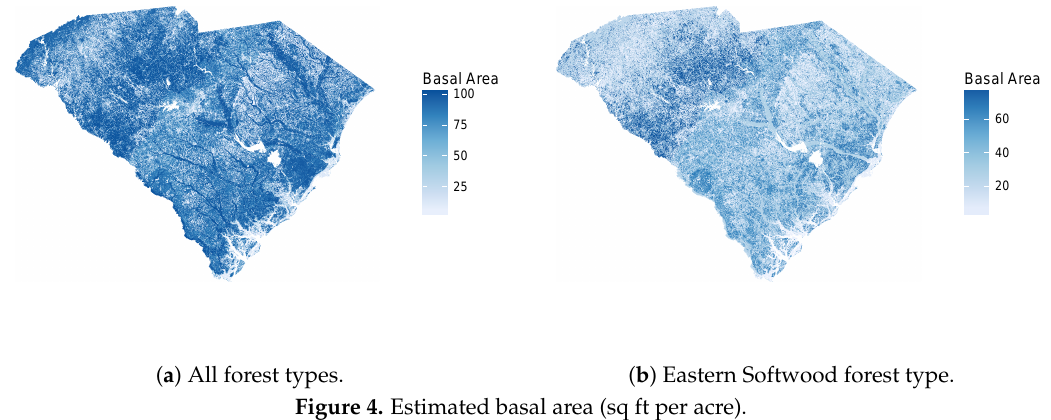
Figure 4. Estimated basal area (sq ft per